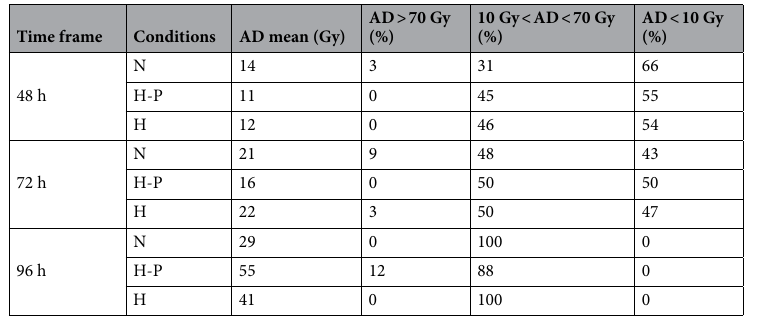
Table 3. Percentage of wells in which absorbed dose (AD) was higher or lower than 10 Gy or 70